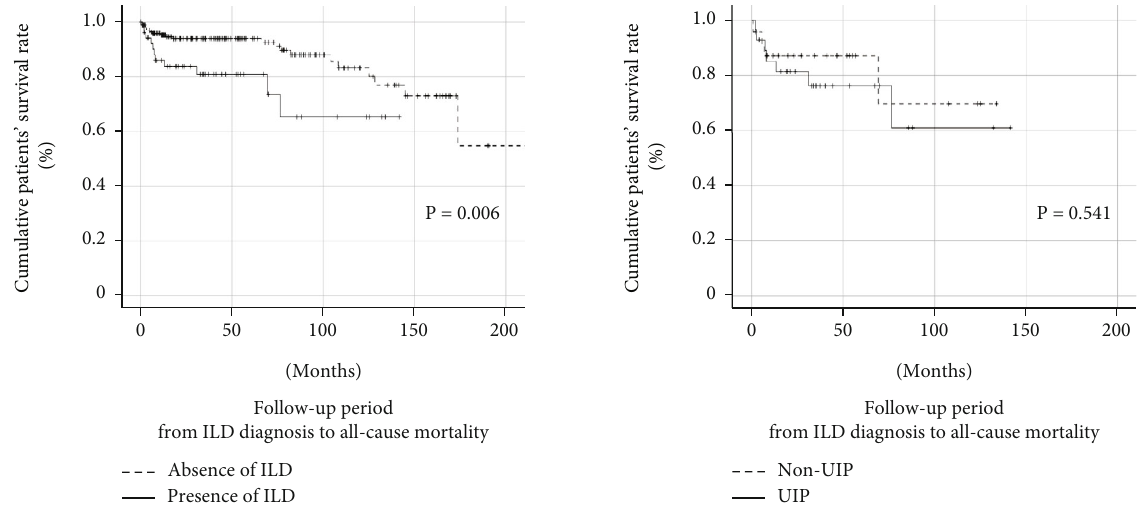
Figure 2: Comparison of cumulative patients ’ survival rates in AAV patients. ILD: interstitial lung disease; UIP: usual pneumonia; AAV: ANCA-associated vasculitis; ANCA: antineutrophil cytoplasmic